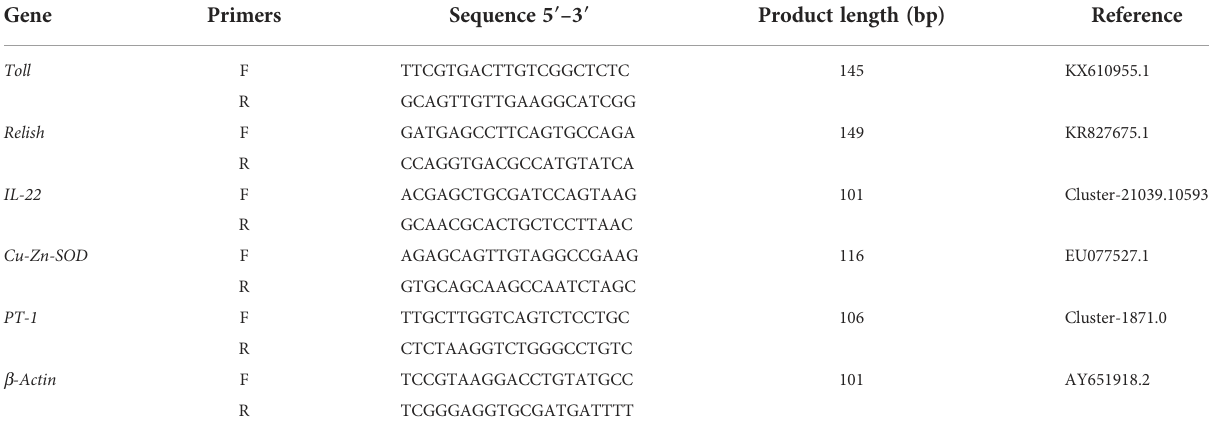
TABLE 2 Primer sequences for real-time